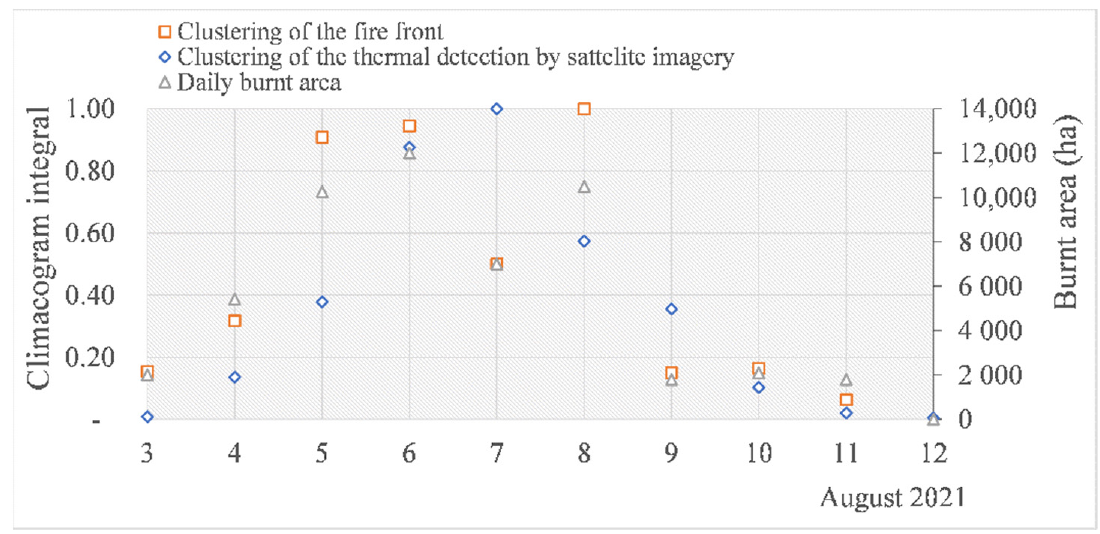
Figure 15. Evolution of clustering of fire front, thermal detection, and daily burnt area.